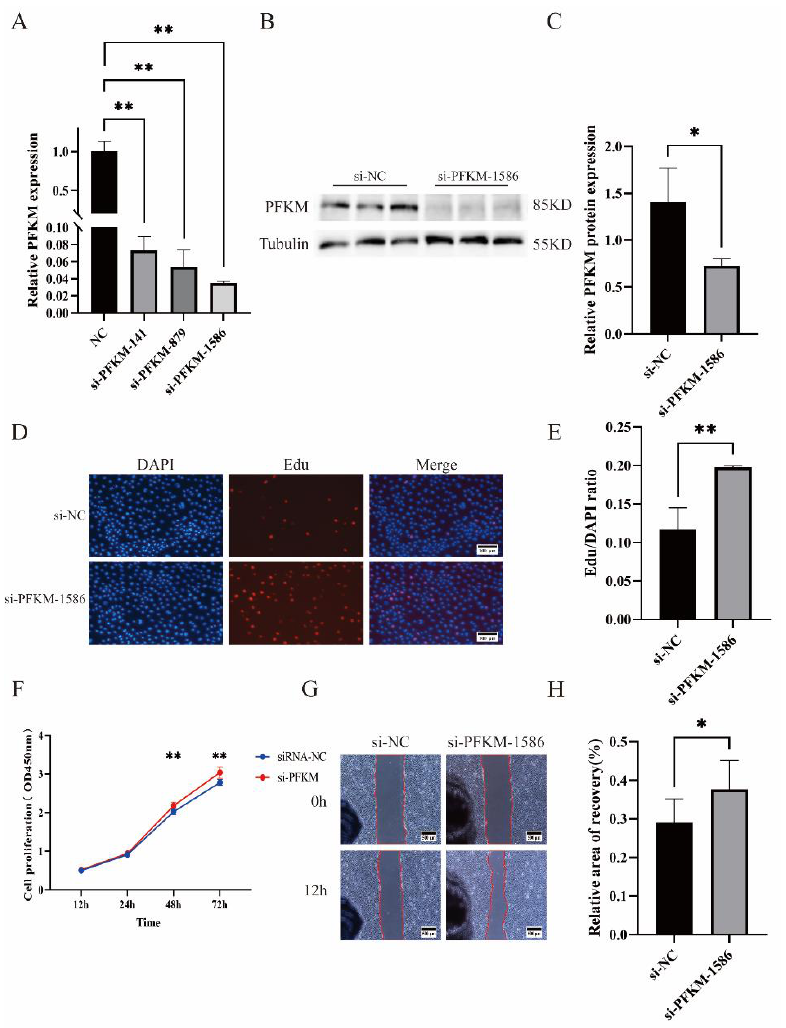
Figure 4. Functional effects of interference on PFKM gene expression in PTr2. ( A ) Three interfering fragments of the PFKM gene were constructed, of which si- PFKM -1586 demonstrated the most potent interference and was therefore used in all subsequent experiments. ( B , C ) Protein blot analysis revealed that si- PFKM -1586 significantly interferes with PFKM protein expression. ( D – F ) CCK-8 and Edu results showed that interfering with the PFKM gene promotes PTr2 proliferation. ( G , H ) Interfering with PFKM gene expression promotes PTr2 migration. Data are expressed as the means ± SEM of three experiments. (* p < 0.05; ** p <